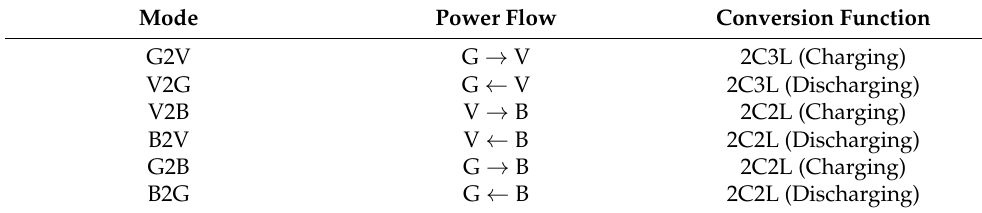
Figure 2. Three-port power conversation with 2C3L and 2C2L resonant circuits. Table 1. Six power conversion modes of the